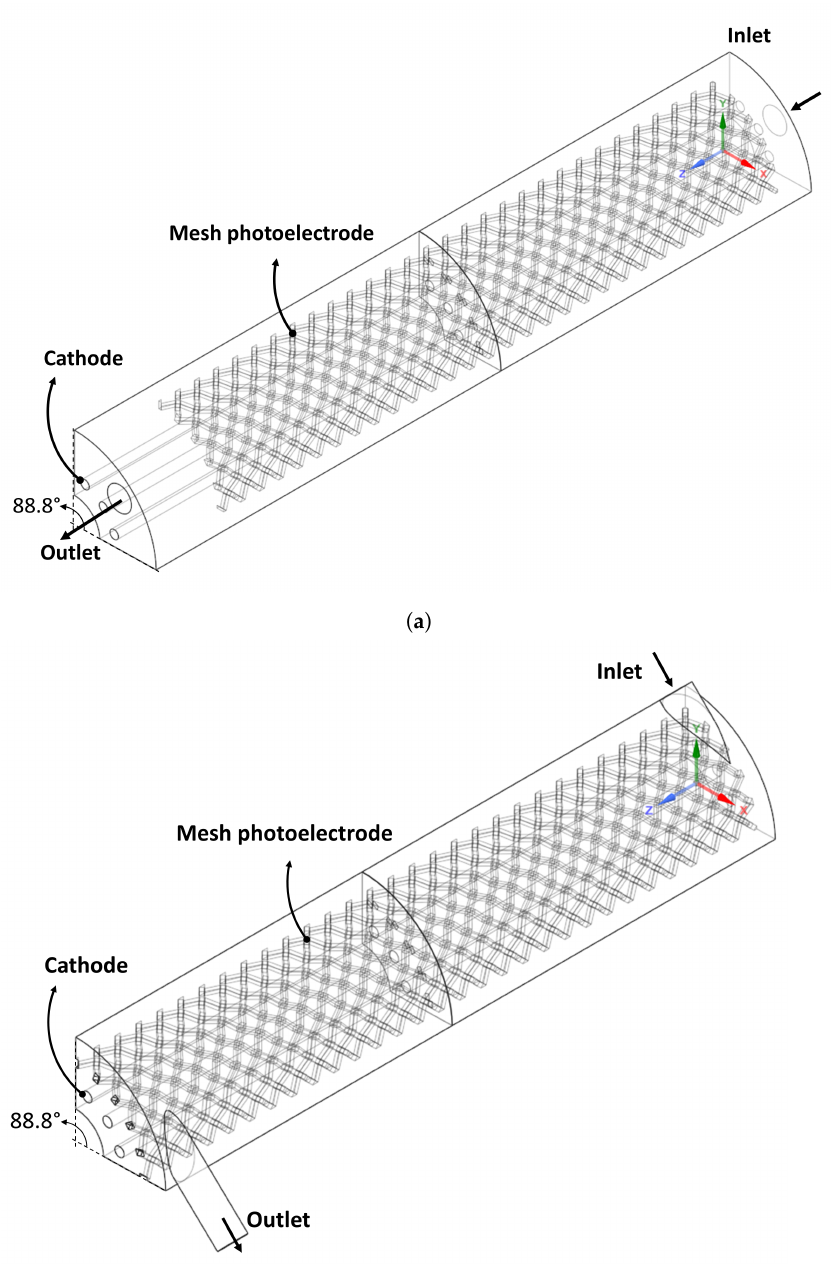
Figure 4. Computational domains used in CFD simulations, ( a ) AF and ( b )